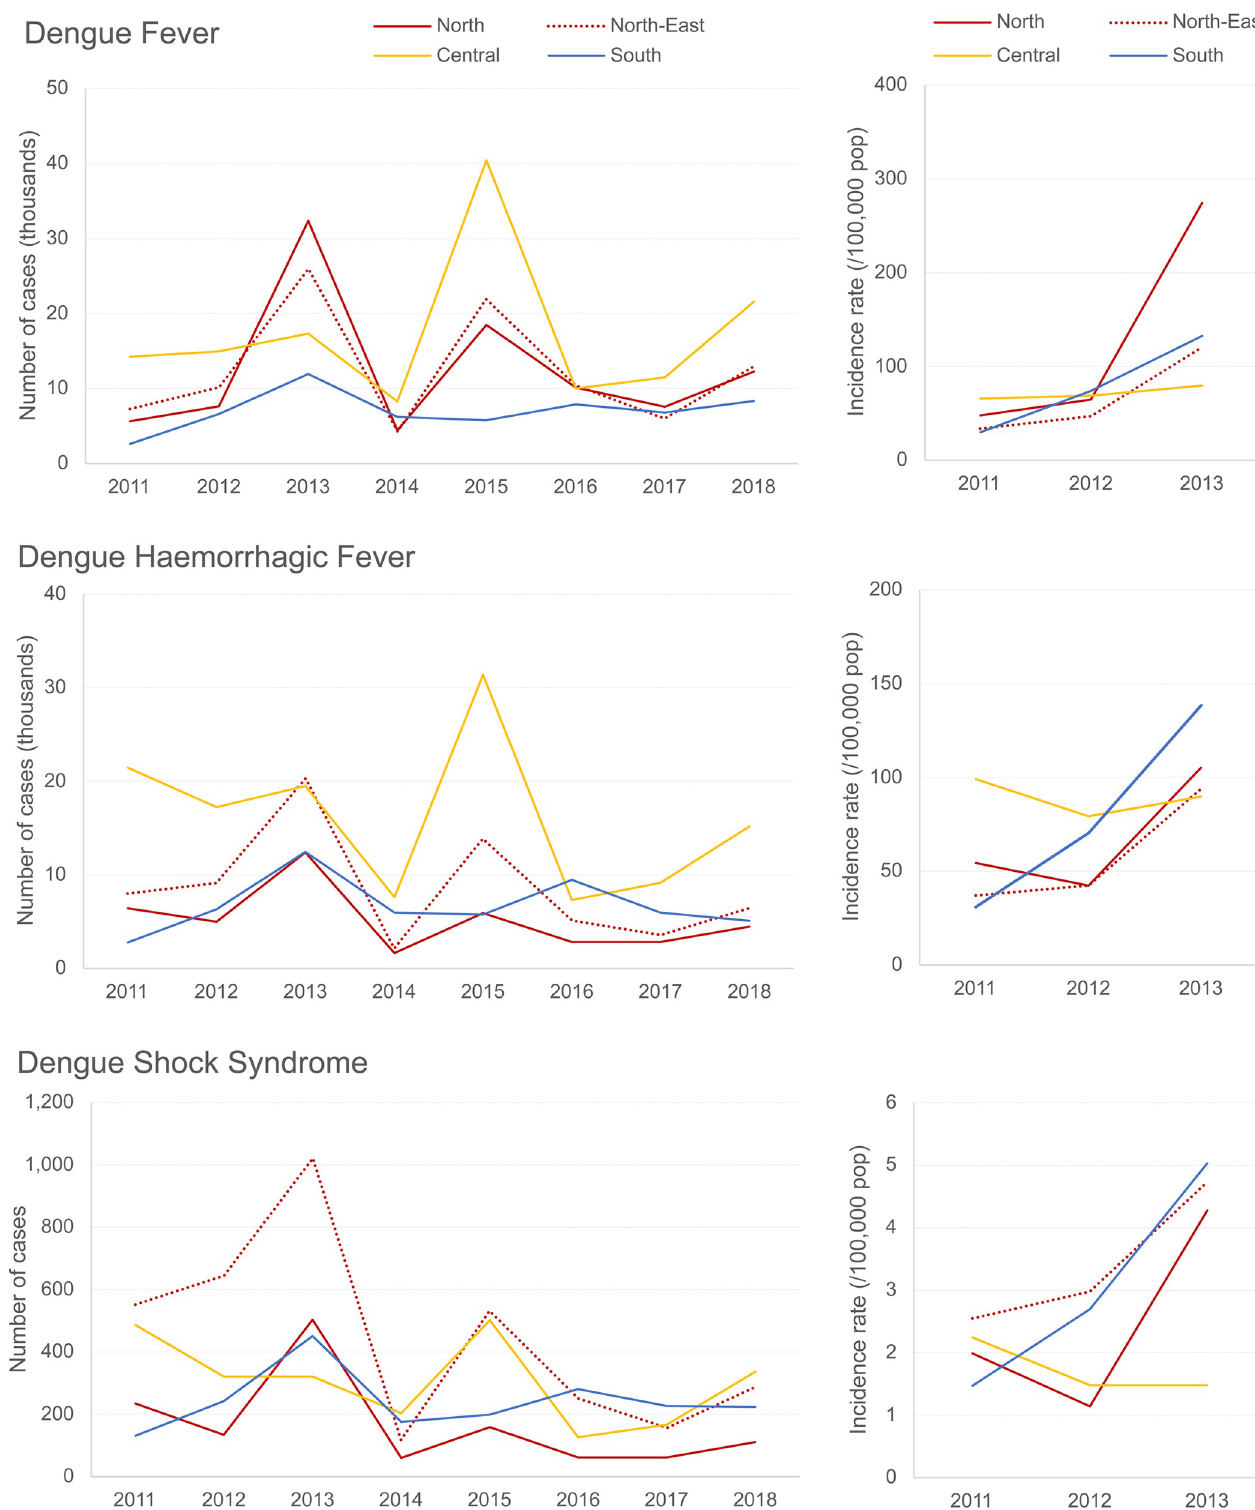
Fig 5. Regional number of cases and incidence rates of dengue by 1997 WHO case definition between 2011–2018; Source MoPH [12].